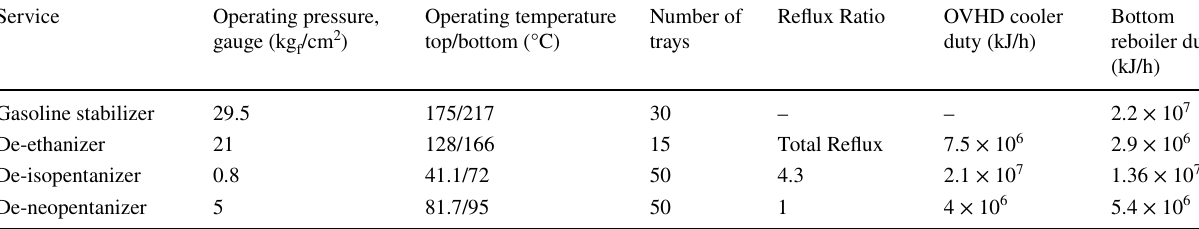
Table 11 Towers process input data